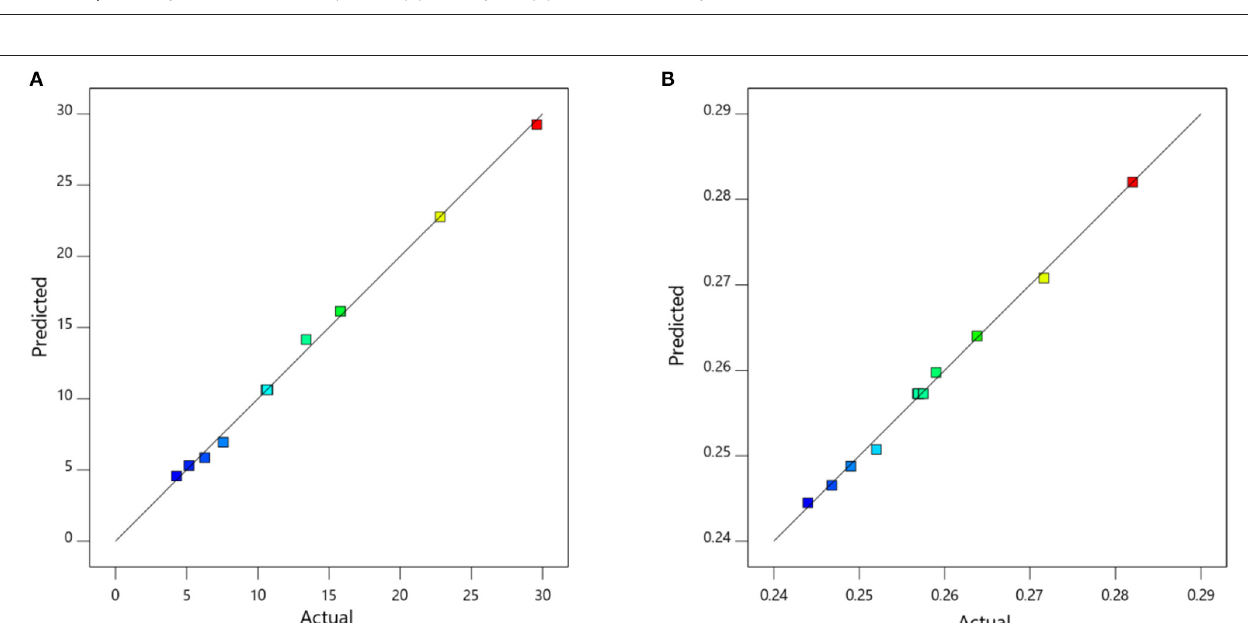
FIGURE 3 | Validation of models using actual (experimental data) for (A) viscosity and (B) thermal conductivity.